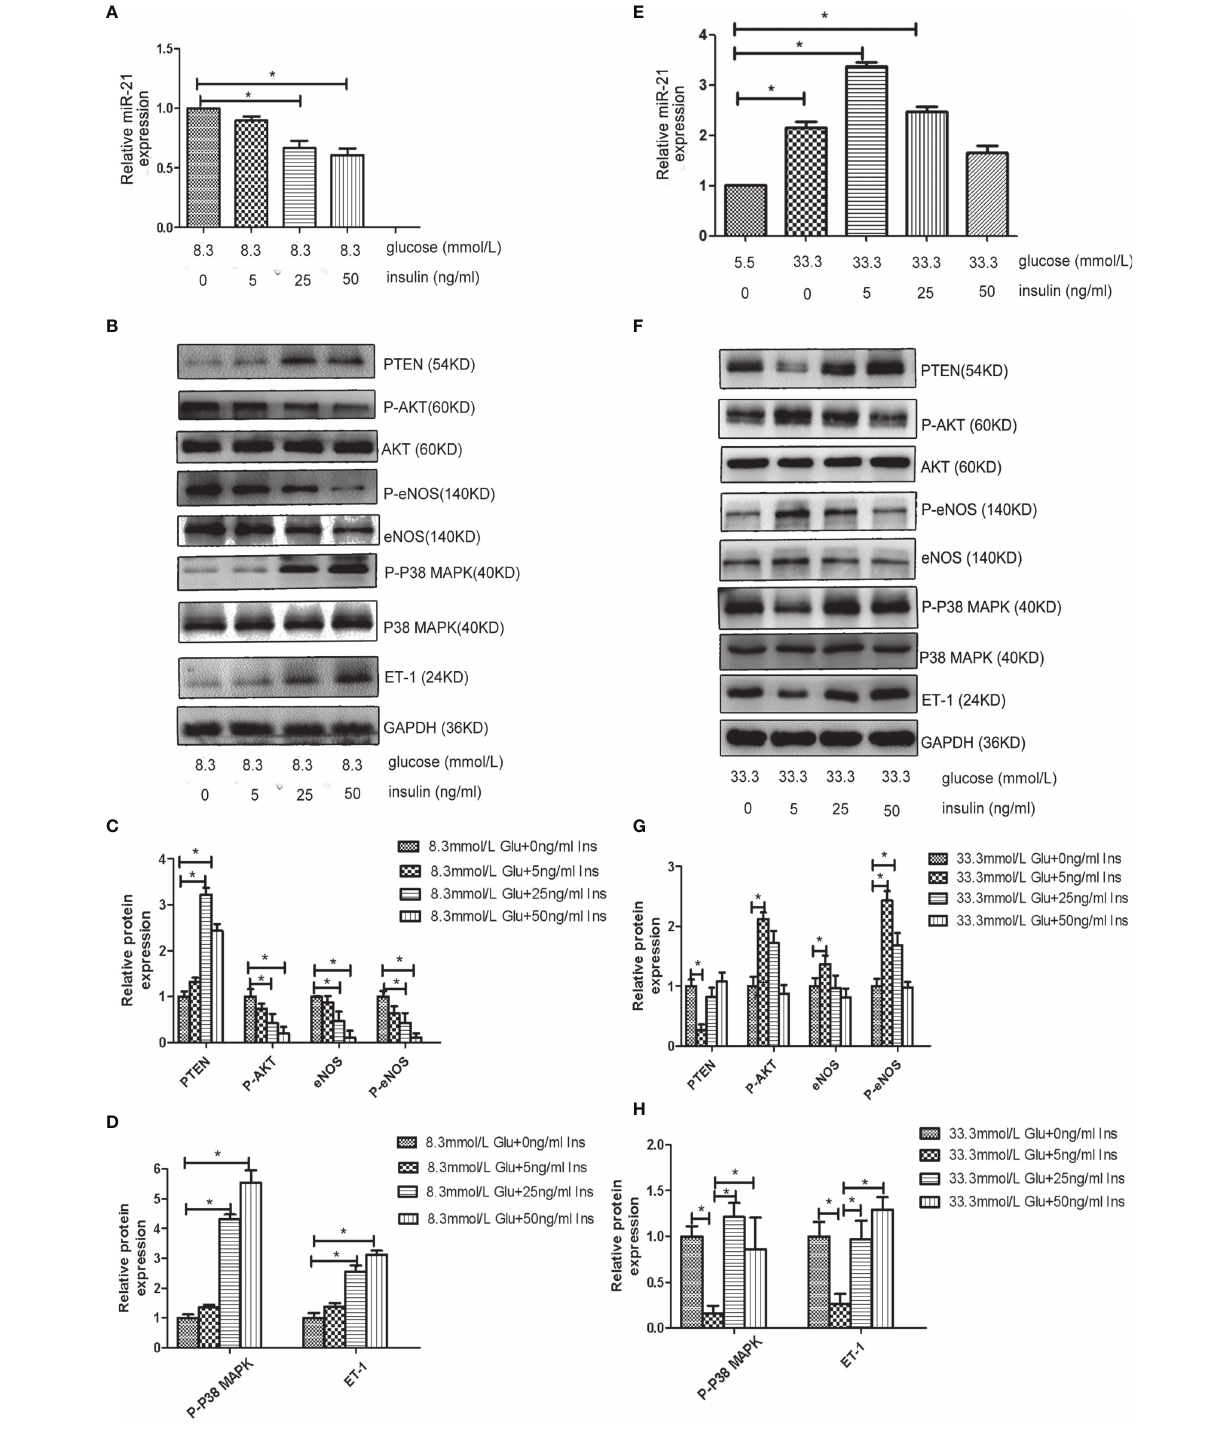
FIGURE 3 | Effects of combined treatment of HGECs with high concentrations of glucose and insulin on the expression of miR-21, PTEN/AKT/eNOS, and MAPK/ET-1 pathways. (A) : qRT-PCR analysis of miR-21 in HGECs treated with 8.3 mmol/L of glucose together with different concentrations of insulin. (B) : Protein expression of the PTEN/AKT/eNOS and MAPK/ET-1 pathways in groups in (A). (C, D) : Quanti fi cation of result in (B). (E) : qRT-PCR analysis of miR-21 in HGECs treated with 33.3 mmol/L of glucose together with different concentrations of insulin. (F) : Protein expression of the PTEN/AKT/eNOS and MAPK/ET-1 pathways in groups in (E). (G, H) : Quanti fi cation of result in (F) . Data are reported as mean ± SD, *P < 0.05. All data are representative of three independent experiments. Glu, glucose; Ins,